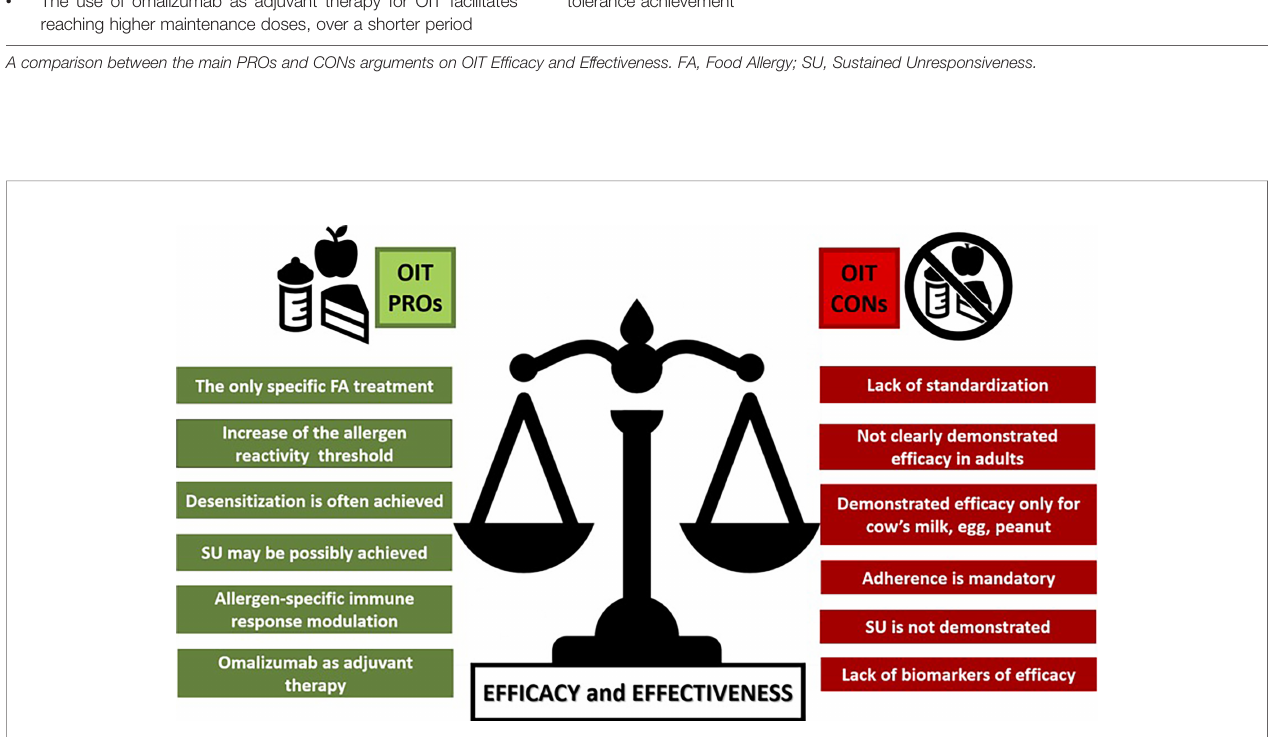
FIGURE 1 | A comparison between the main PROs and CONs arguments on OIT Ef fi cacy and Effectiveness. FA, food allergy; SU, sustained unresponsiveness.